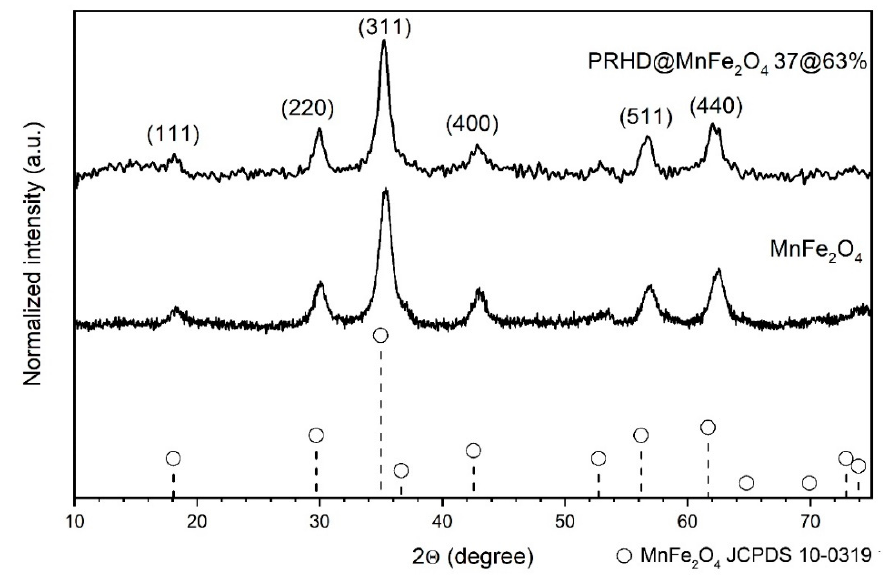
Figure 1. Comparison of the XRD patterns of stock MnFe 2 O 4 nanoparticles with PRHD@MnFe 2 O 4 hybrid material.